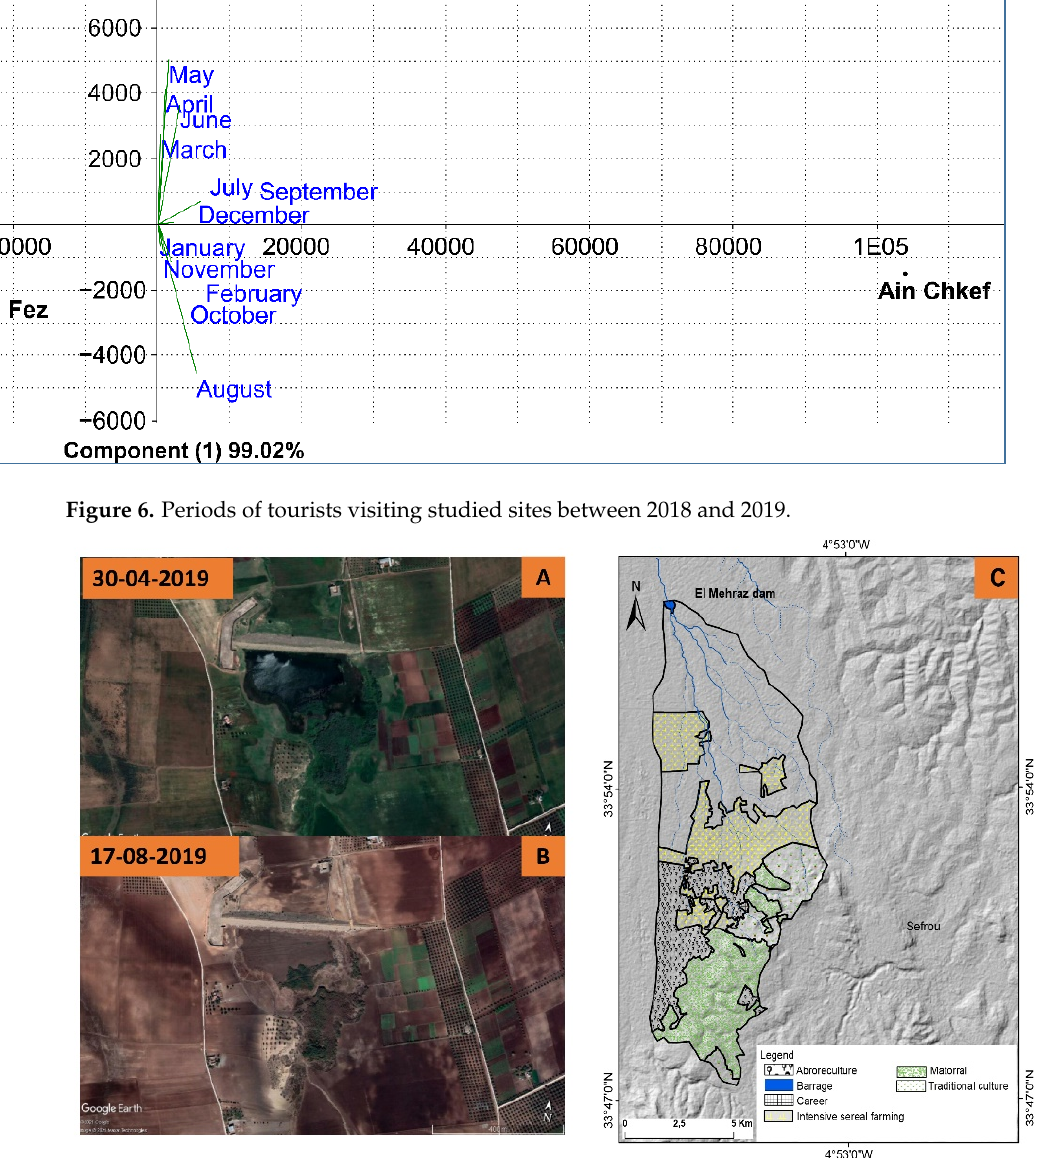
Figure 7. The impact of farmlands developed in the El Mehraz watershed: ( A ) availability of water in the dam reservoir; ( B ) dry reservoir, and ( C ) watershed farmlands.